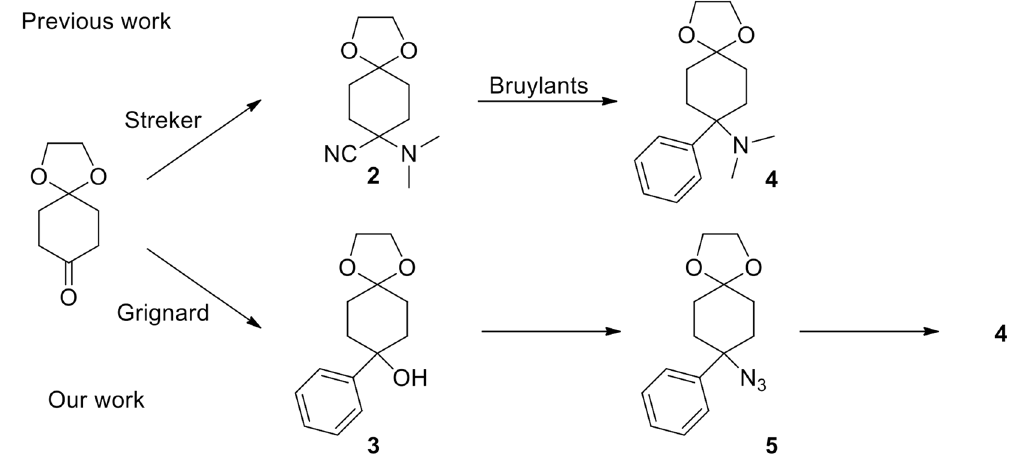
Figure 3. Different approaches to the synthesis of Cebranopadol.